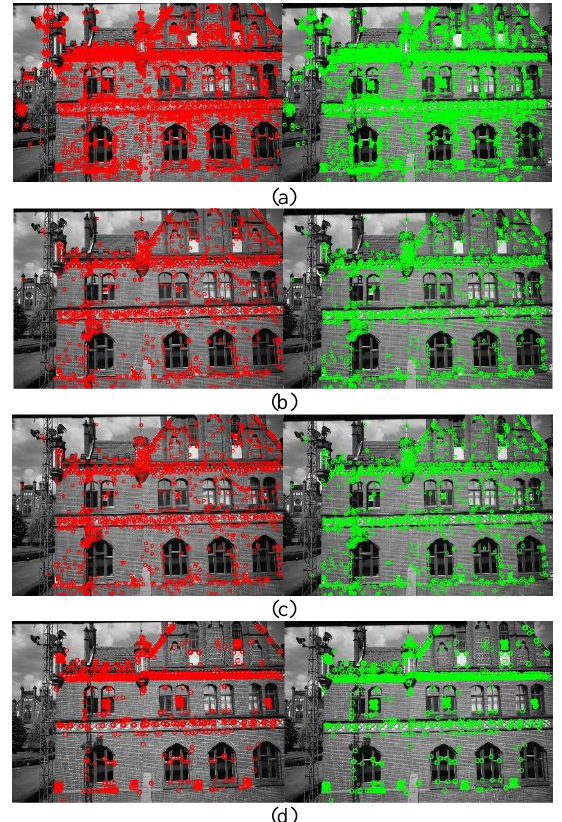
Figure 7. Feature correspondence for the first image pair. Results obtained using (a) the proposed method, (b) SIFT+RANSAC, (c) SURF+RANSAC, and (d) ORB+RANSAC. Table 2. Matching measures for the first image pair when using SIFT, SURF, ORB and our proposed method.